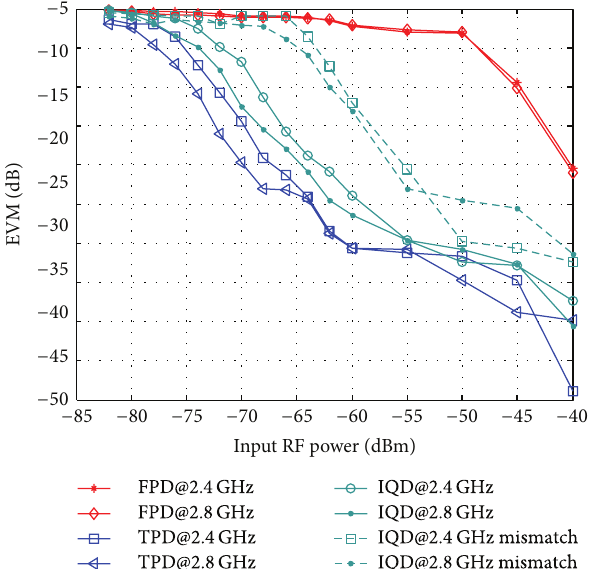
Figure 9: Baseband spectrum at the output of the 𝐼/𝑄 regeneration circuit ( 𝐼 path) for FPD, TPD, and IQD after downconversion of three RF carriers @2 GHz, 2.4 GHz, and 2.8 GHz to DC and 40MHz and 80MHz.